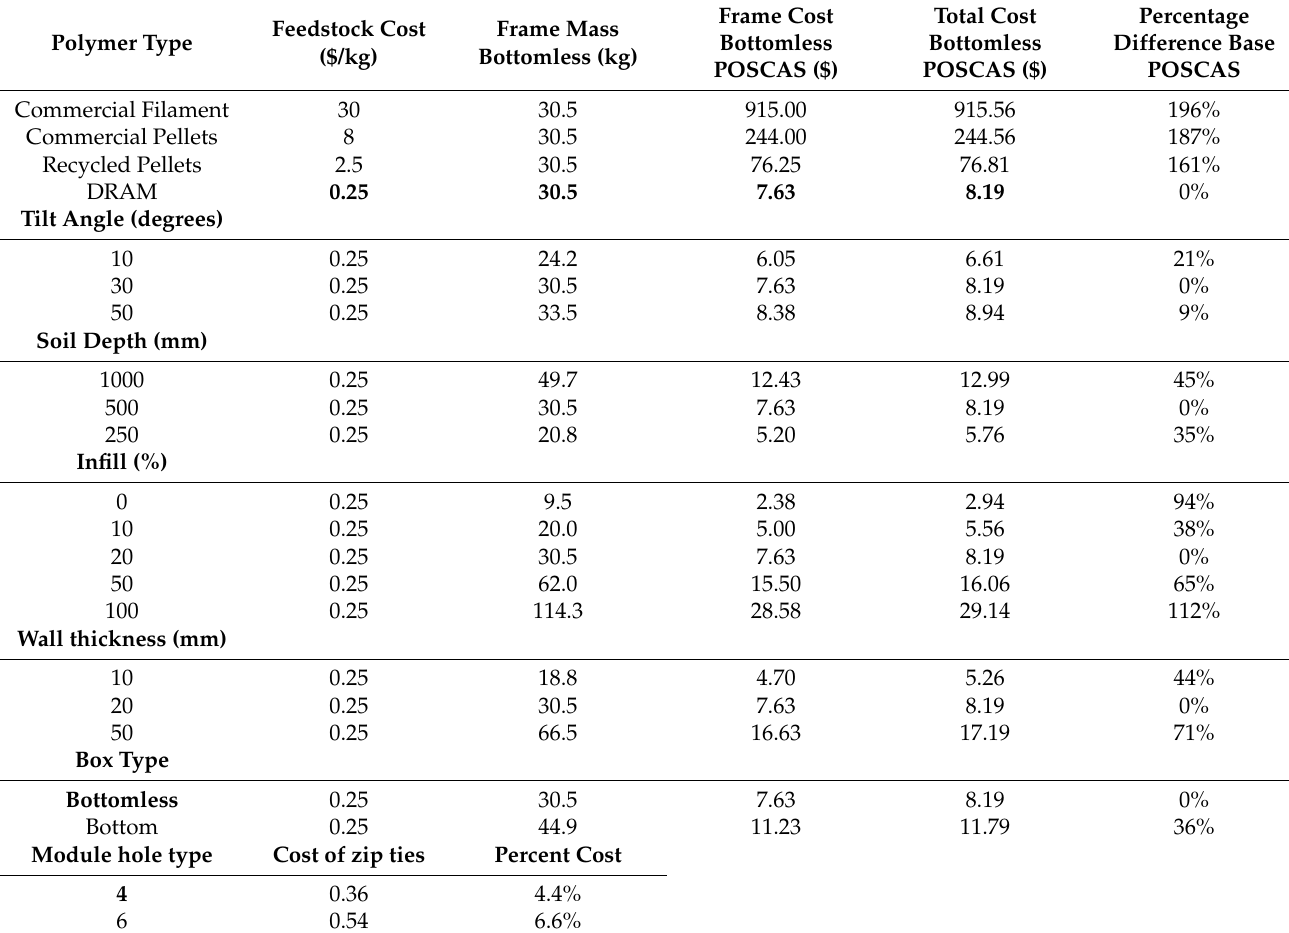
Table 3. Economic sensitivities of POSCAS production; all values in US$. Bold values are the base POSCAS